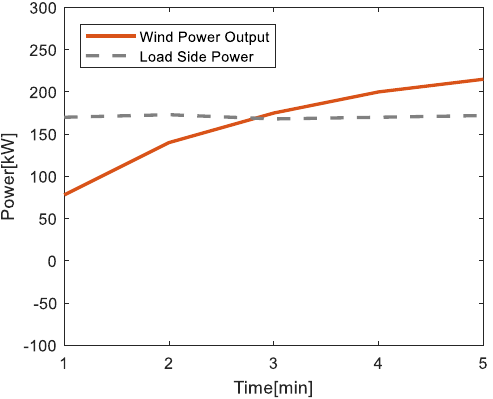
Figure 1. Wind farm power and its corresponding load conditions in period 1.